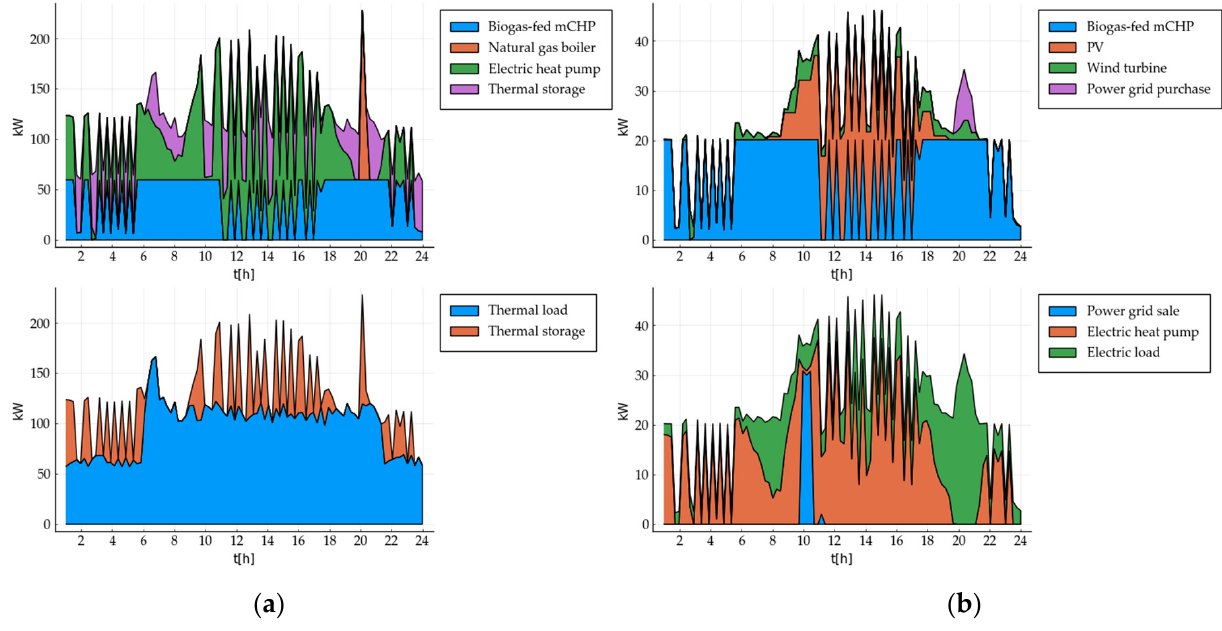
Figure 8. Daily consumption and production pattern for Case 1: thermal production ( a -up) consumption ( a -down); electricity production ( b -up) consumption ( b